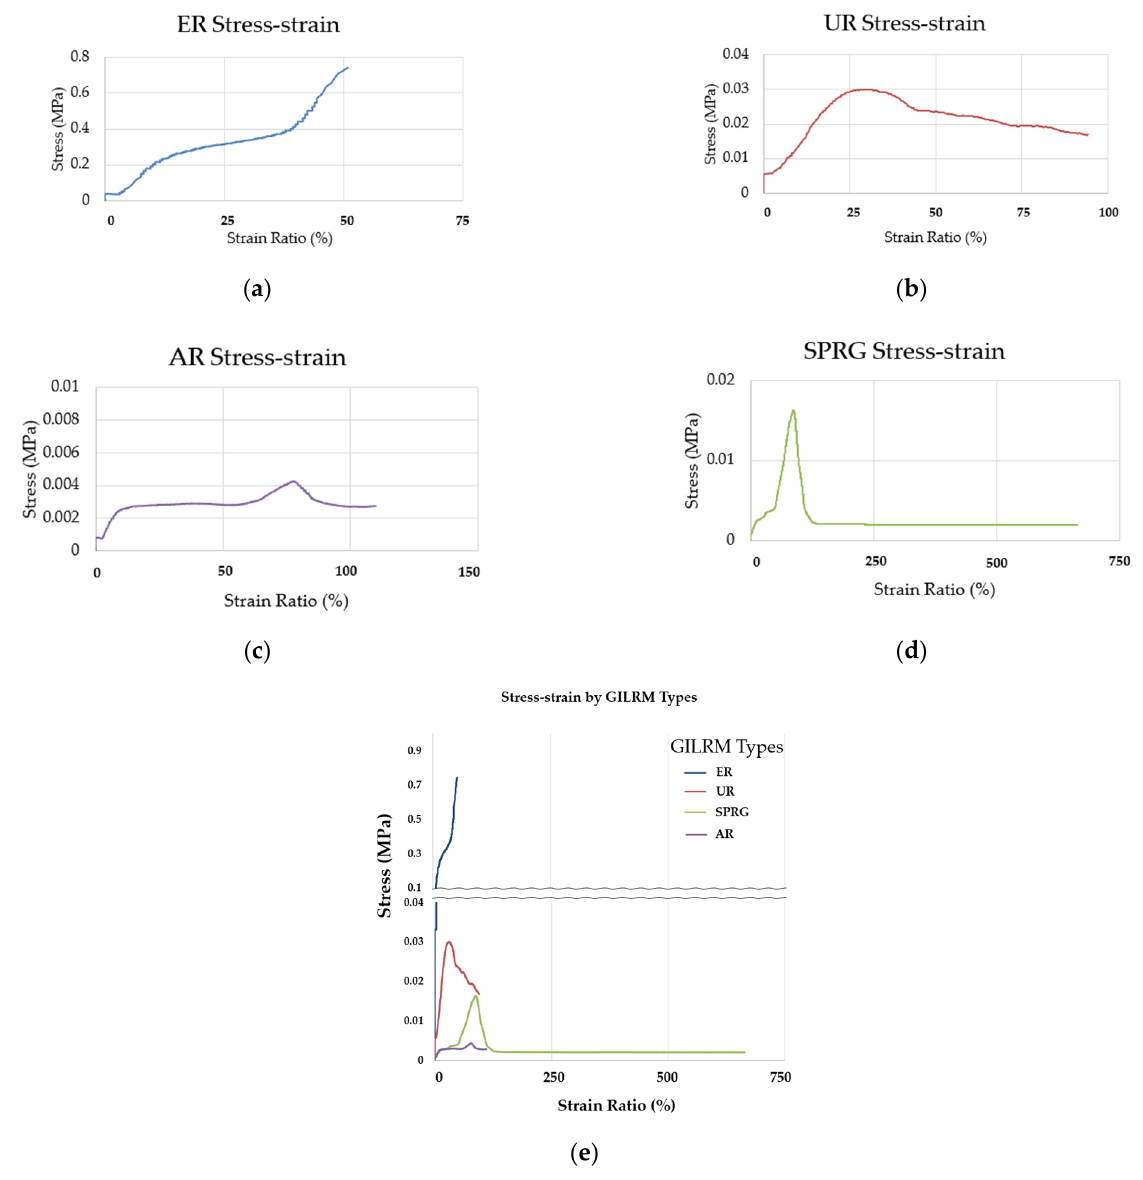
Figure 4. Adhesive stress-strain curve for each material, ( a ) ER results, ( b ) UR results, ( c ) AR results, ( d ) SPRG results, ( e ) comprehensive results (all GILRM types).